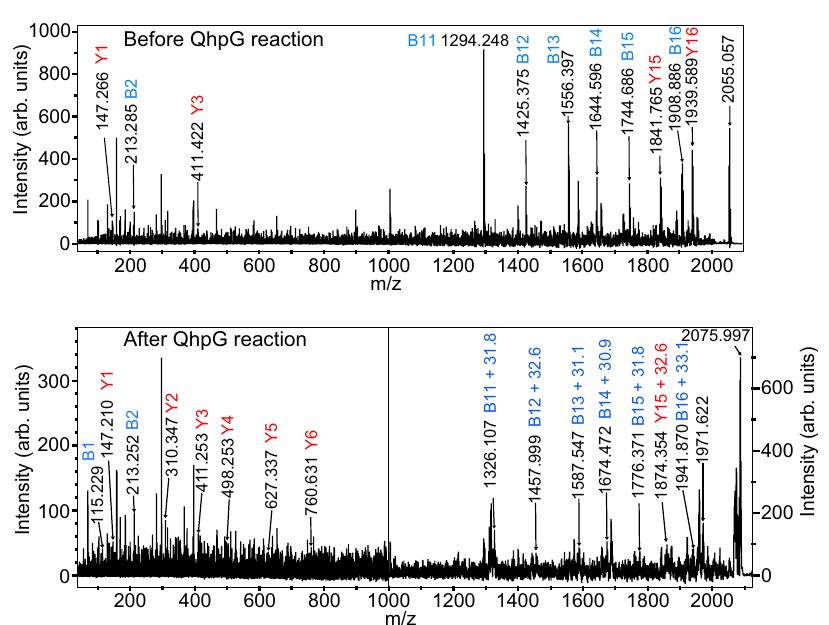
Fig. 4 MS/MS analysis of peptide fragment produced by QhpG reaction. Predicted fragmentation pattern of fragment d (Asp39 – Gln55) is shown above. MS/MS spectra of the peptides of d and d + 32 peaks obtained before and after the QhpG reaction are shown in upper and lower panels, respectively. Assigned fragments are indicated with m/z